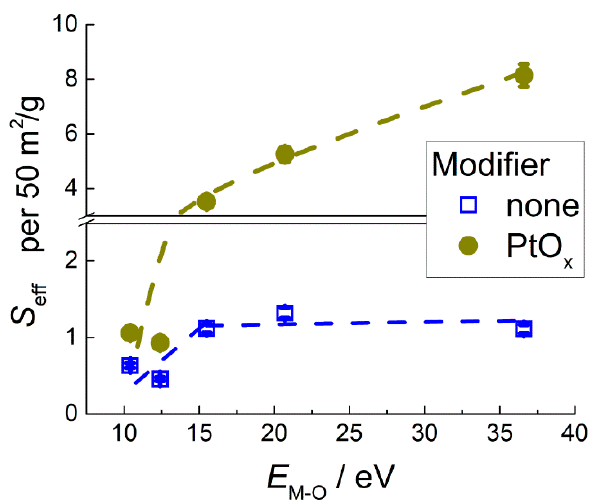
Figure 7. Maximum effective sensor signals of pristine and PtO x − modified MOS to 2 ppm C 6 H 6 in relation to metal–oxygen bond energy in MOS.